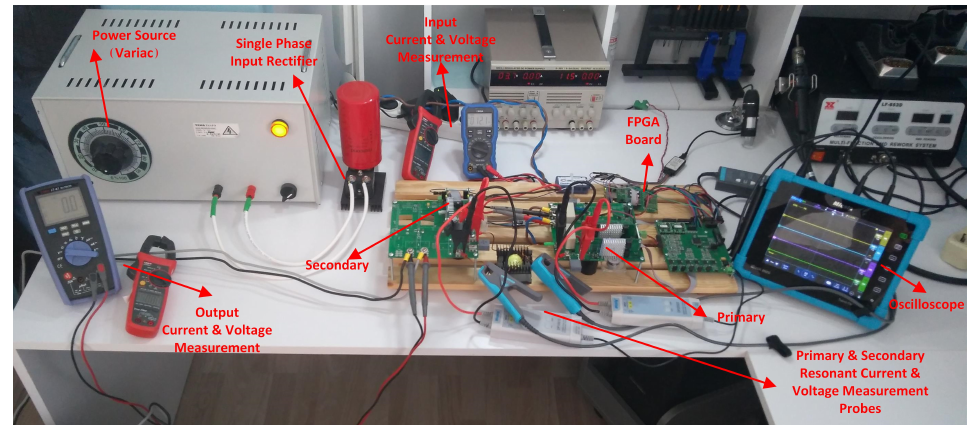
Figure 9. Experimental setup. The block diagram of the experimental setup is given in Figure 10.